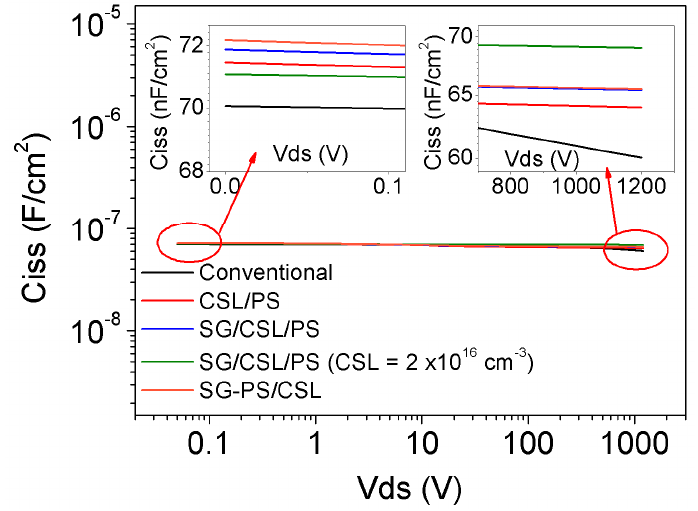
Figure 5. Ciss of conventional, CSL/PS, SG–PS/CSL, and SG/CSL/PS, with different CSL doping concentrations. The frequency is at 1 MHz and Vgs is 0 V. If not otherwise specified, the CSL doping concentration is 9 × 10 16 cm − 3 .